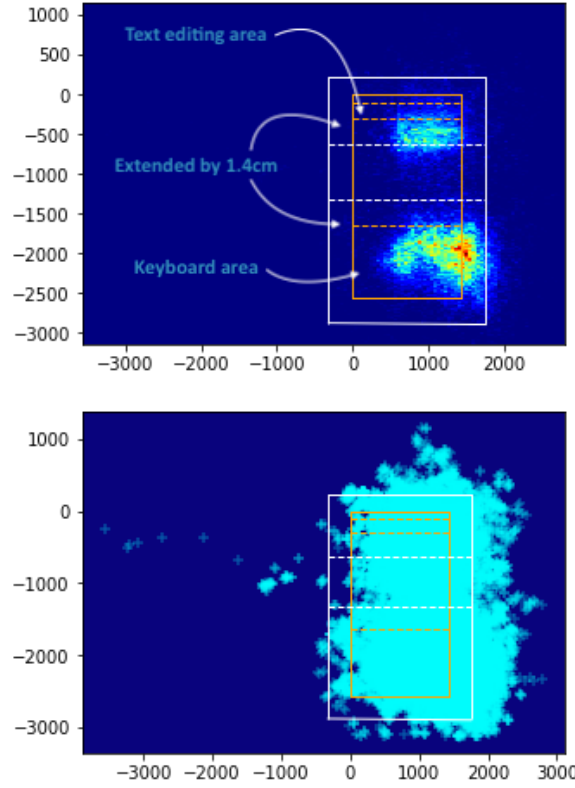
Figure 1. 2D-histogram ( top ) and scatter plot ( bottom ) of raw gaze data, as found in Jiang et al.’s